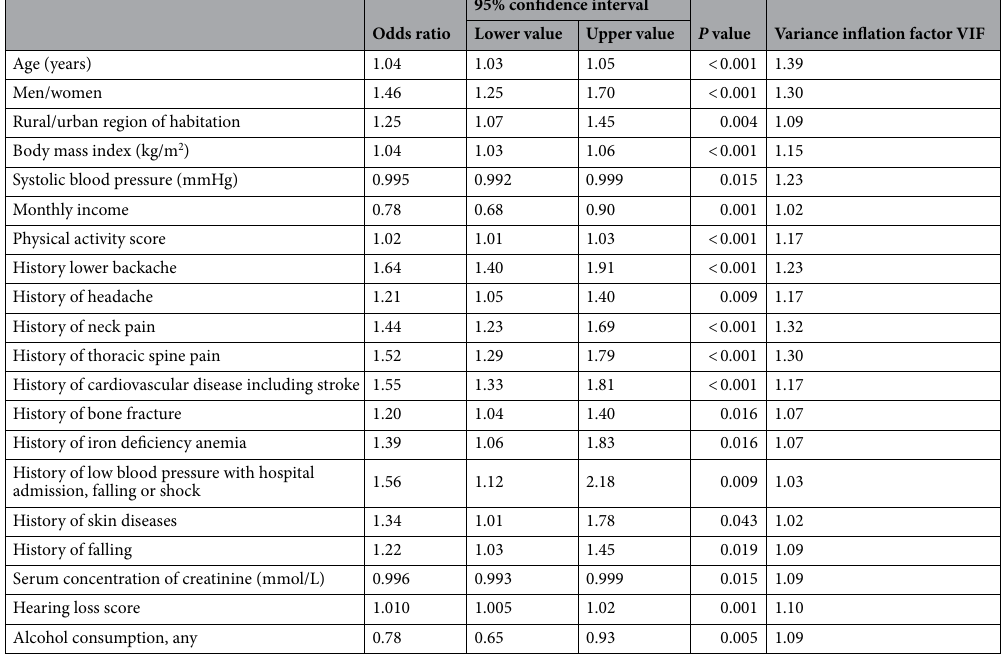
Table 3. Associations (multivariable analysis) between the prevalence of osteoarthritis and other parameters in the Ural Eye and Medical